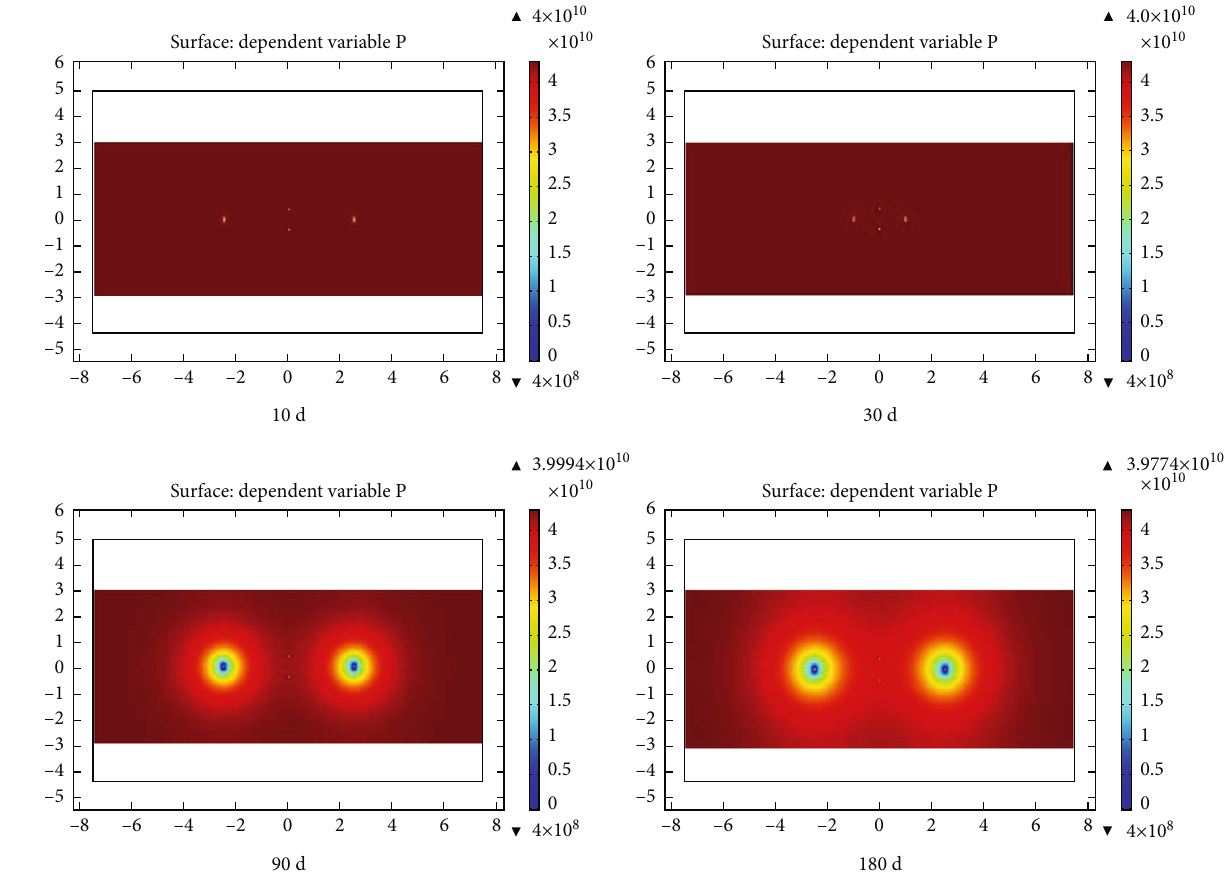
Figure 14: Gas pressure distribution map of liquid carbon dioxide fracturing with 5m spacing between pumping